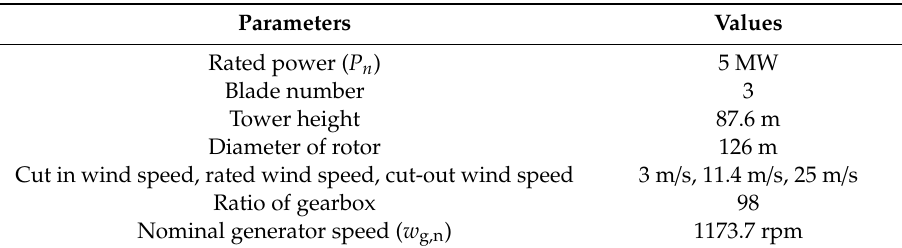
Table 1. Parameters of the 5MW o ff shore WT.